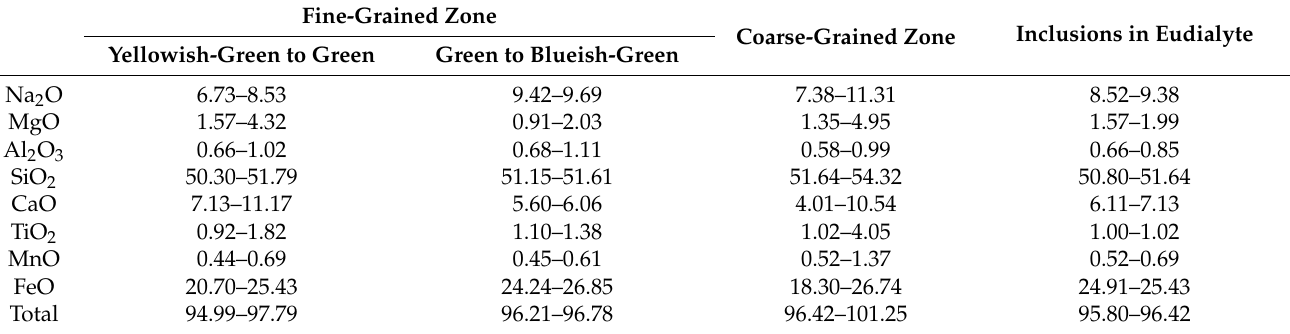
Coarse-Grained Zone Inclusions in Eudialyte